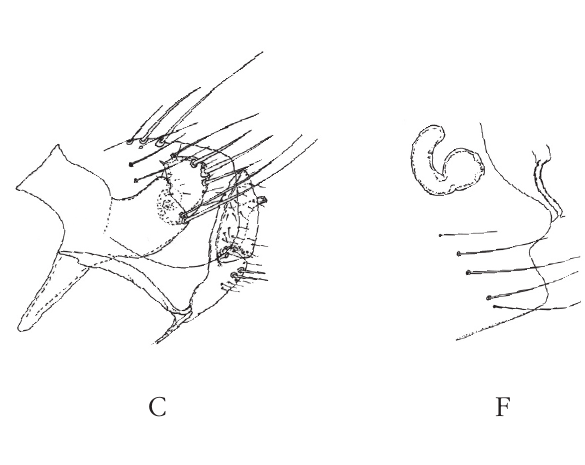
 (Figure 5C) (I.F. Keymer rec. ) ( in : Coll.